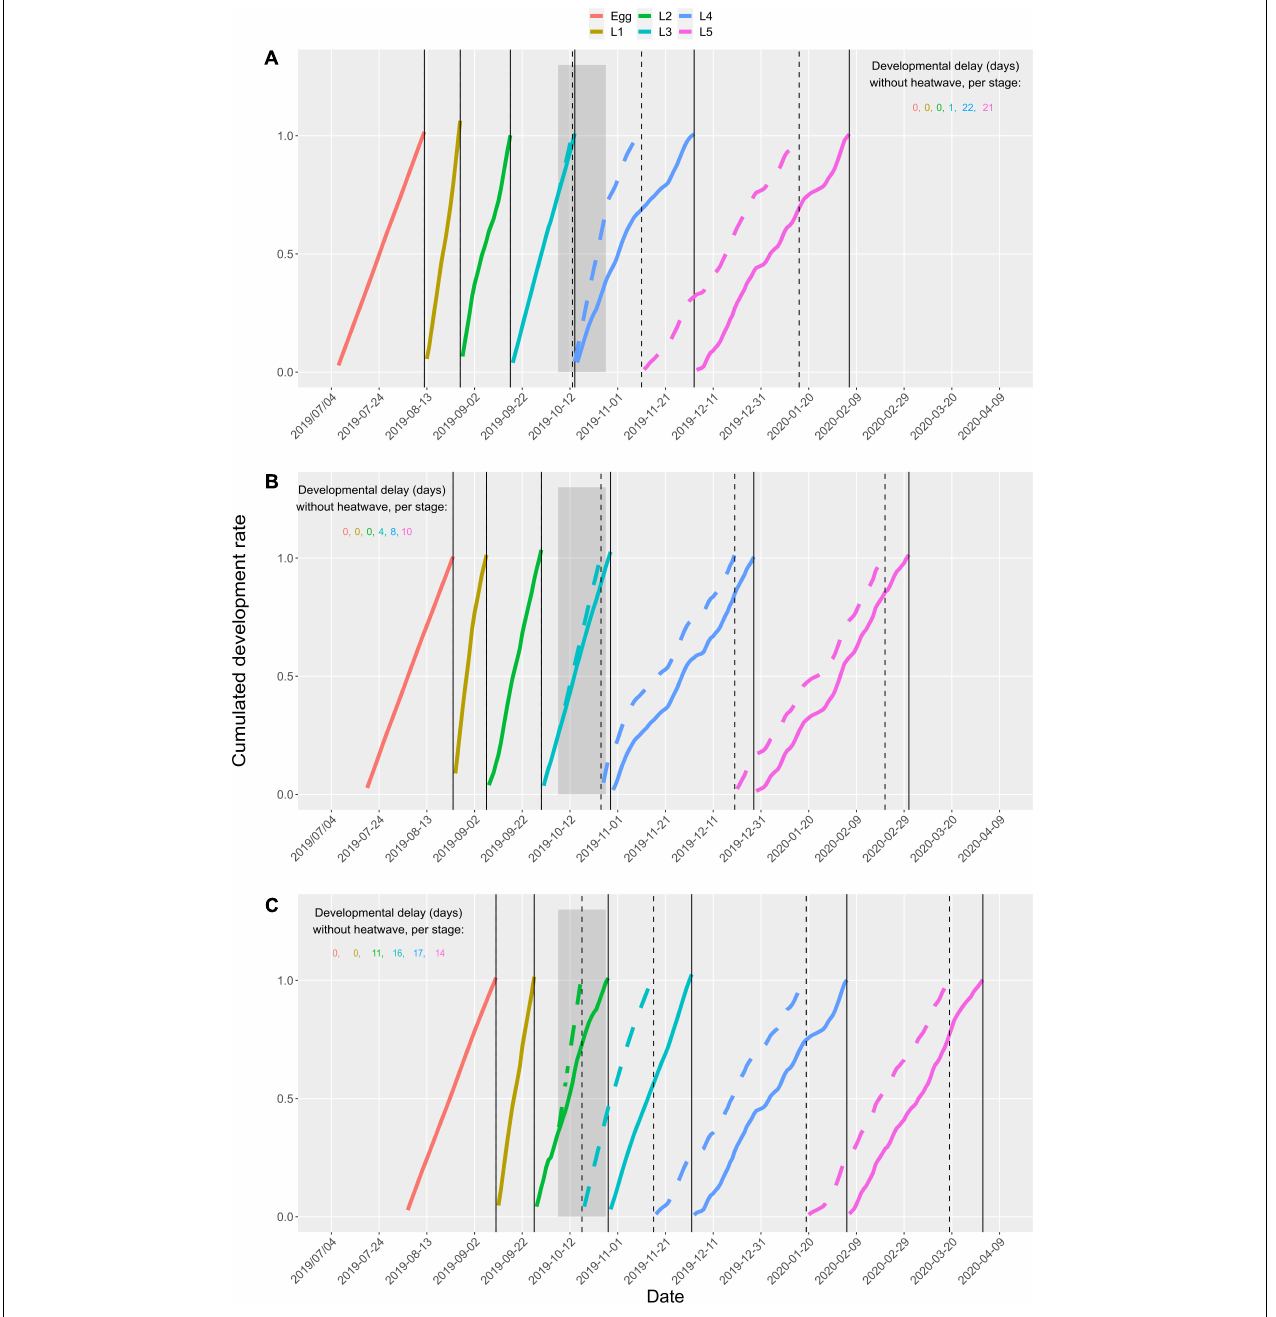
FIGURE 8 | Predicted cumulated development rate of prepupal stages with (dashed lines) or without (solid lines) a + 10 ◦ C autumnal heatwave, represented with the dark gray background from 7 October 2019 to 27 October 27 2019. Panels (A–C) correspond to three cohorts of eggs laid at the 10, 50, and 90% quantiles of previous generation adult trappings (6 July 6 2019, A ; 18 July 18 2019, B ; 4 August 2019, C ). Captures of adults from the previous generation (parents) are assumed to reflect egg quantiles given the short adult lifespan of the PPM. Simulations were computed with a temperature baseline corresponding to the daily mean temperature recorded in Orléans in 2019–2020. Color curves represent predicted cumulated development time for each stage simulated with (dashed) and without (solid) a + 10 ◦ C autumnal heatwave. Vertical lines mark the predicted end of each stage in the scenario with (dashed) or without (solid)